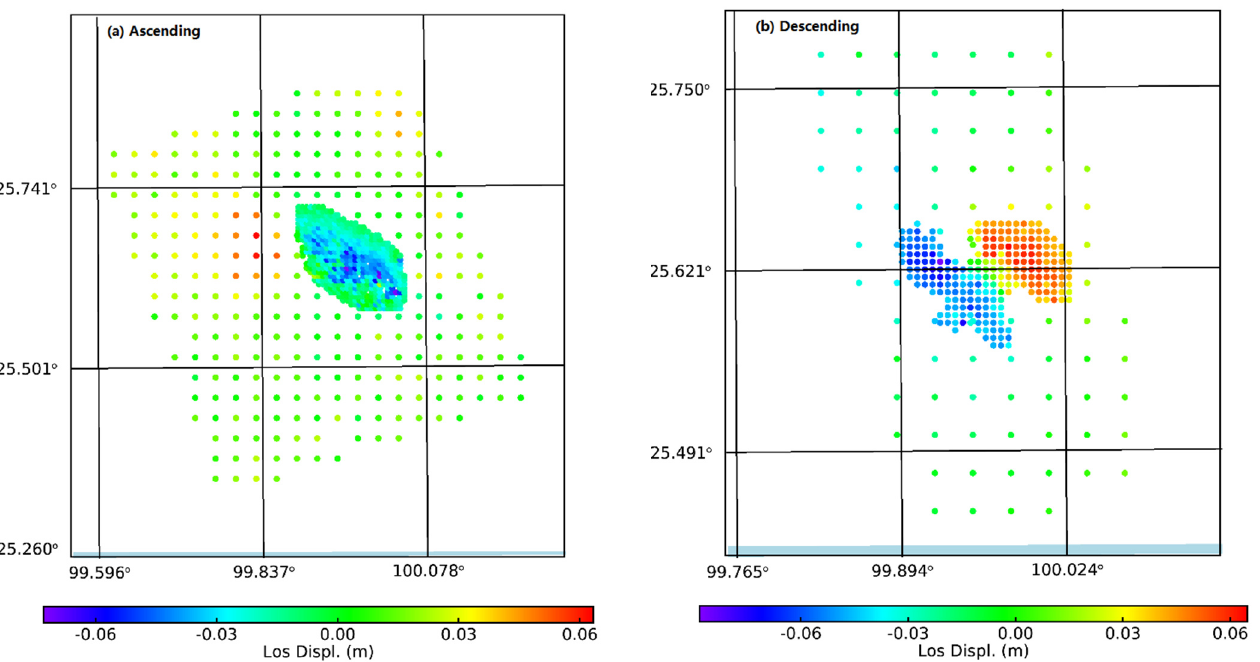
Figure 3. Deformation field down-sampling results of ascending and descending: ( a ) the ascending deformation field down-sampling result; ( b ) the descending deformation field down-sampling re- sult.